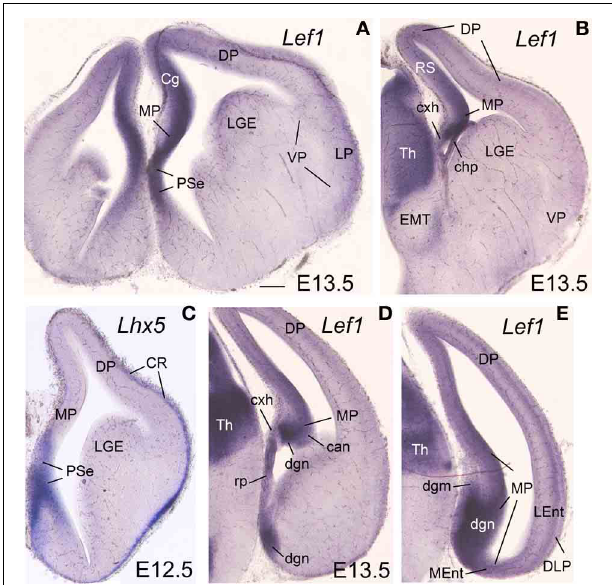
FIGURE 1 | Expression of Lef1 in mouse embryonic telencephalon at E13.5. Digital images of coronal sections of mouse embryonic telencephalon (E13.5), from rostral (A) to caudal (E) levels, hybridized for Lef1 . Note the strong expression in the ventricular zone of the medial pallium and pallial septum. For abbreviations see list. Scale bar: (A) = 200 μ m (applies to